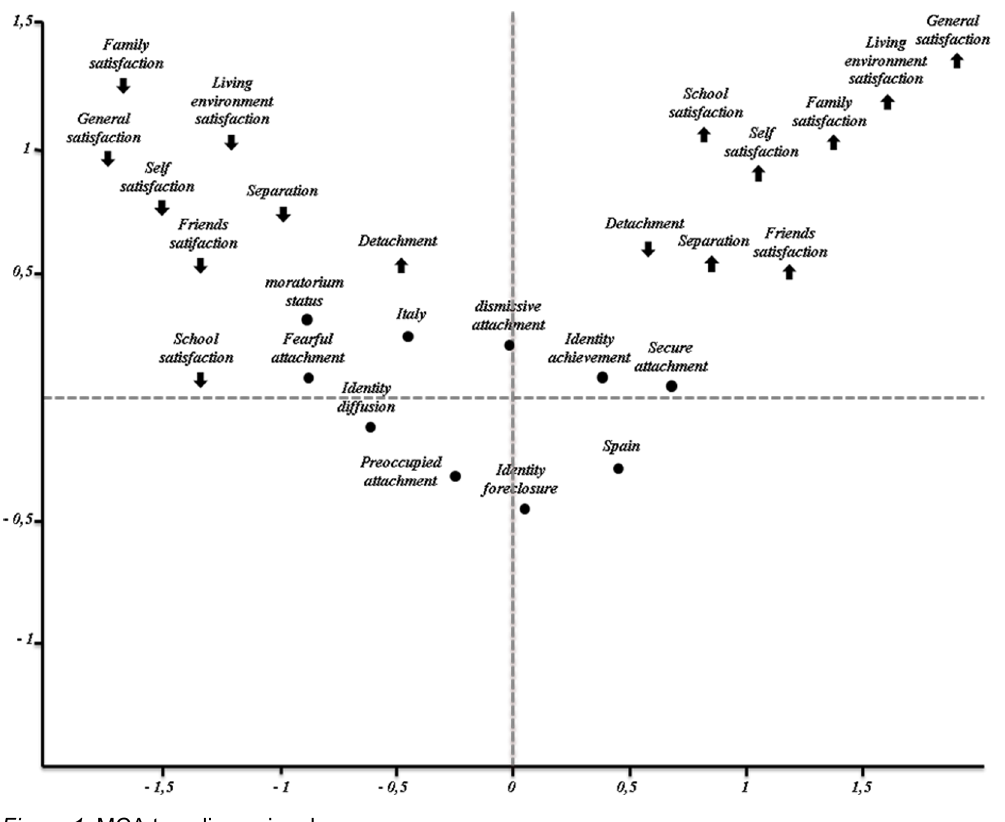
Figure 1. MCA two-dimensional